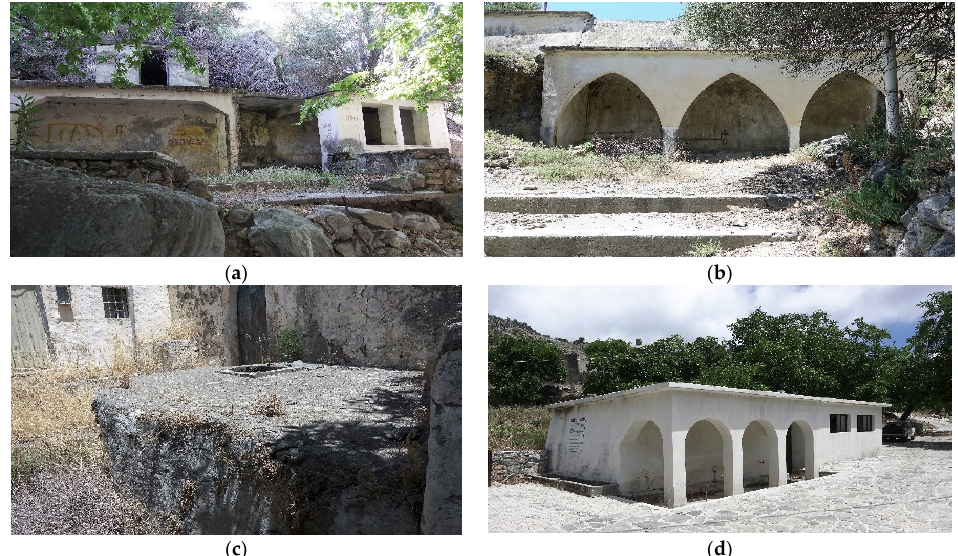
Figure 14. Rainwater cisterns in four settlements: ( a ) Asfentou, ( b ) Vouva, ( c ) Imbros and ( d ) Aradena (photos by A. N. Angelakis).